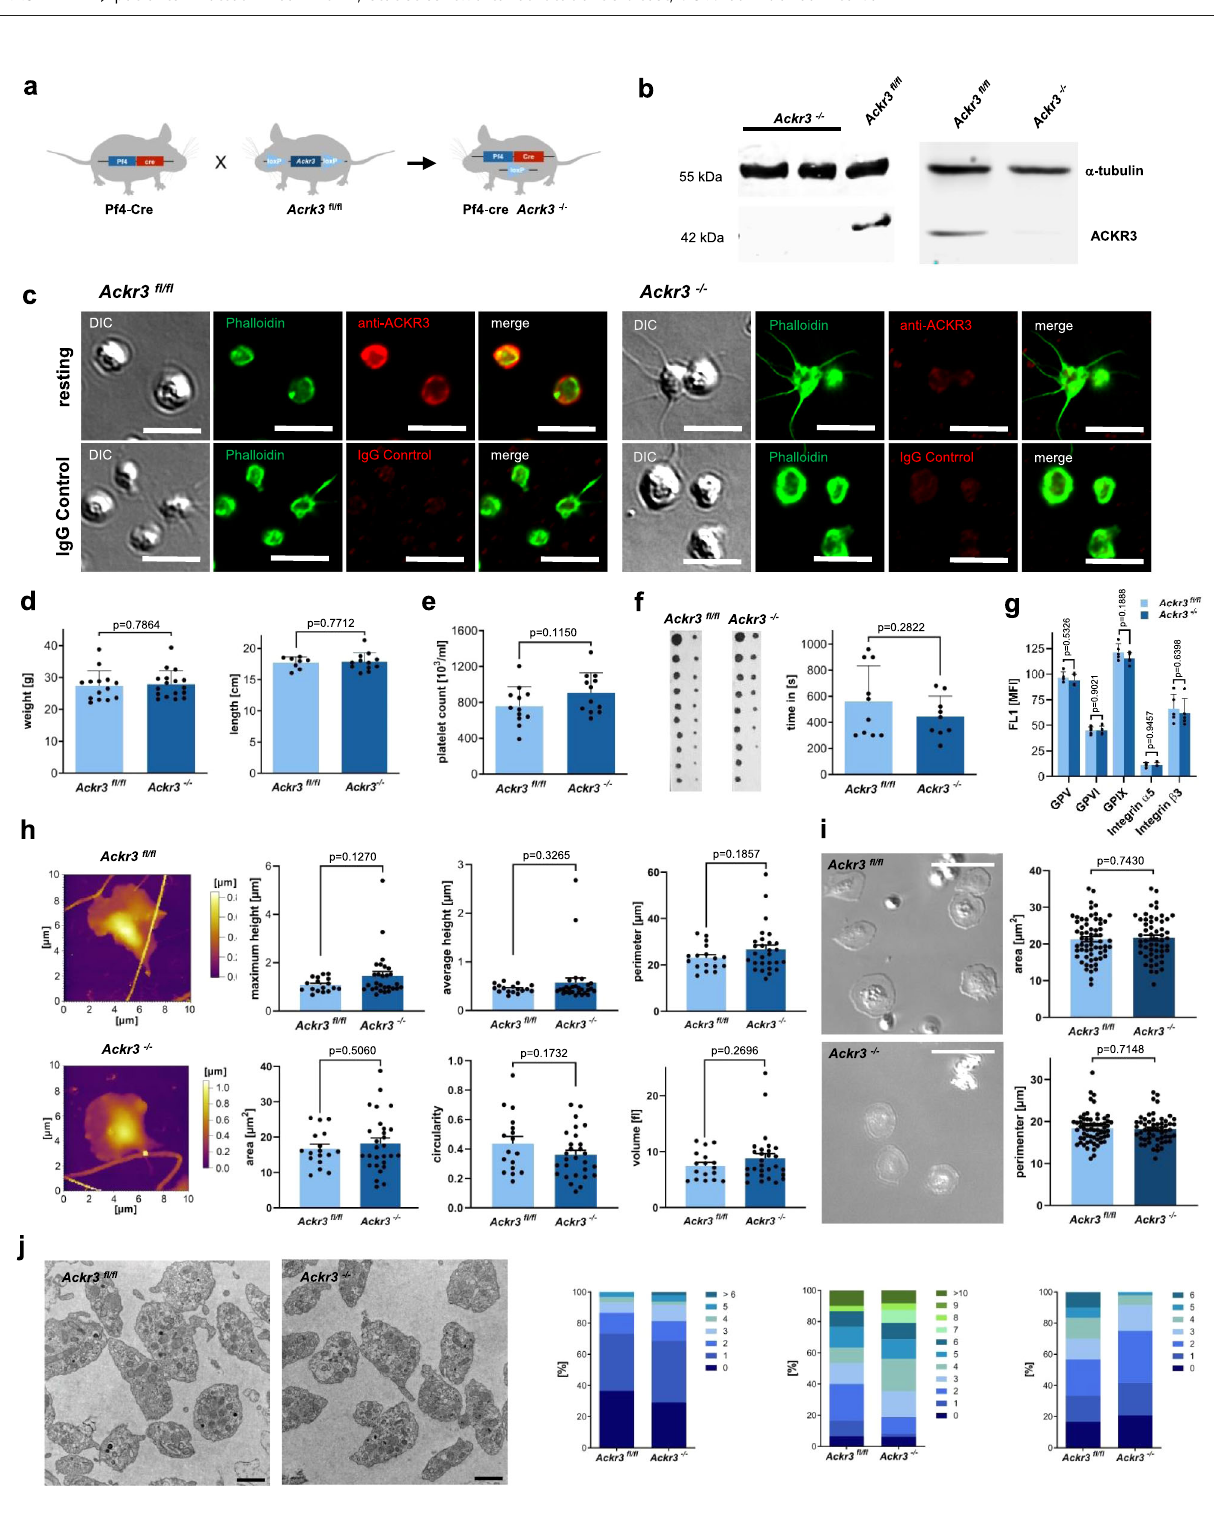
Fig. 1 Platelet surface expression of ACKR3 and clinical prognosis. a Kaplan – Meier curves showing all-cause mortality strati fi ed according to low (1st tertile) vs high (2nd and 3rd tertile) platelet ACKR3 surface exposure levels in patients with symptomatic CAD ( n = 320). b Bar diagrams showing all- cause mortality strati fi ed according to low (1st tertile) vs high (2nd and 3rd tertile) platelet ACKR3 surface exposure levels in the overall cohort as well as CCS ( n = 172) and ACS ( n = 160) patients. c Bar diagrams (mean ± S.E.M.) showing multiplate ® multiple electrode aggregometry with thrombin receptor activating peptide (TRAP) stimulation strati fi ed according to low (1st tertile) vs high (2nd and 3rd tertile) platelet ACKR3 surface exposure levels in the overall cohort (low ACKR3: n = 107; high ACKR3: n = 213) as well as CCS (low ACKR3: n = 51; high ACKR3: n = 103) and ACS (low ACKR3: n = 55; high ACKR3: n = 111) patients. Plotted: mean ± S.D.; statistics: two-tailed Student ’ s t test; 95% con fi dence